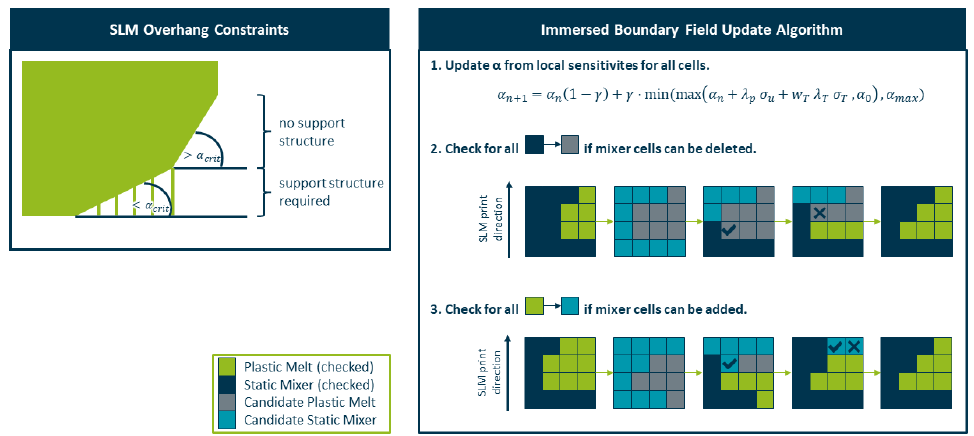
Figure 2. ( Left ) SLM overhang constraints regarding support structures. ( Right ) Schematic of the immersed boundary field update algorithm.